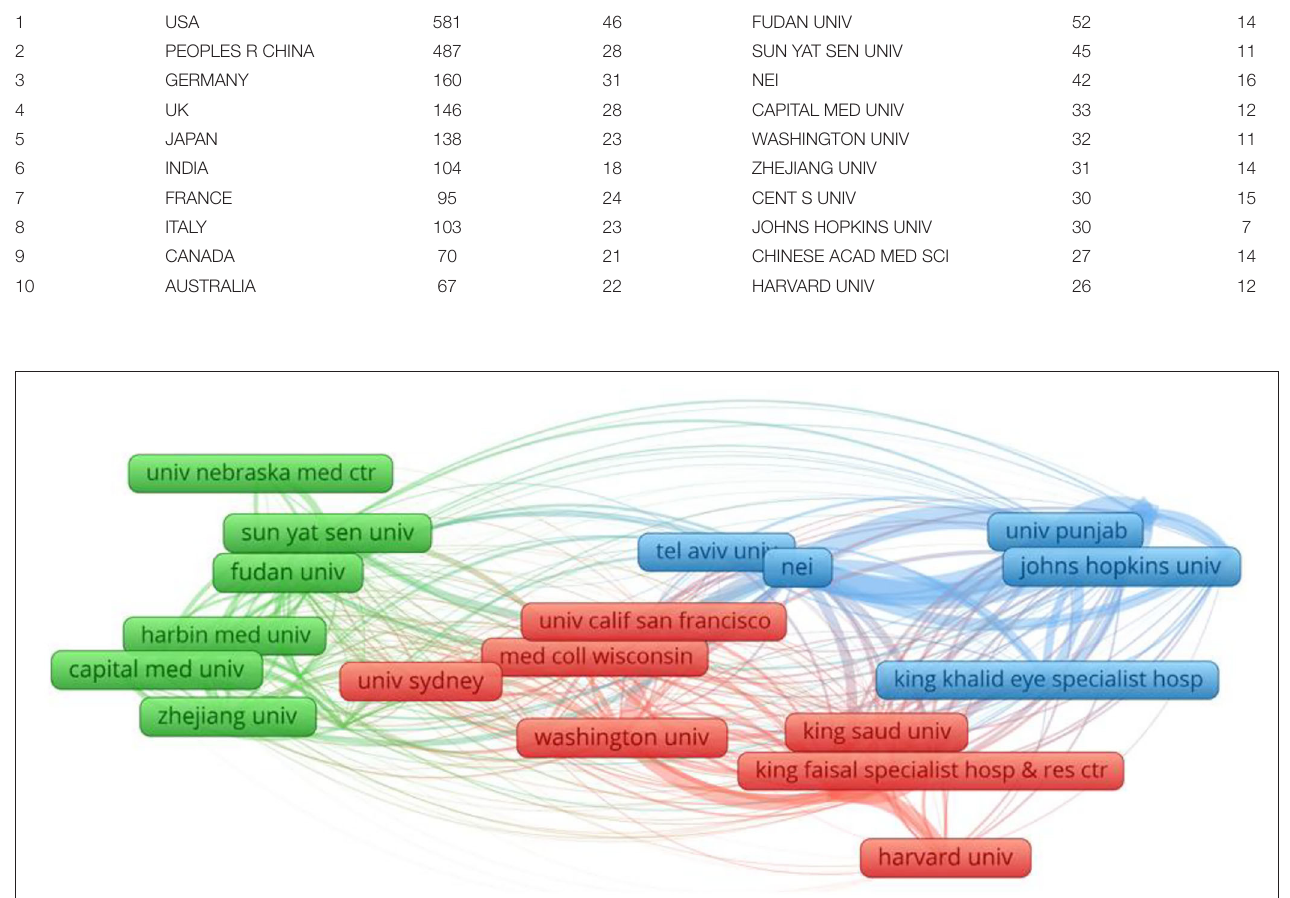
FIGURE 4 | Network map of institutions contributed to publications on Cataract-gene from 2010 to 2019.